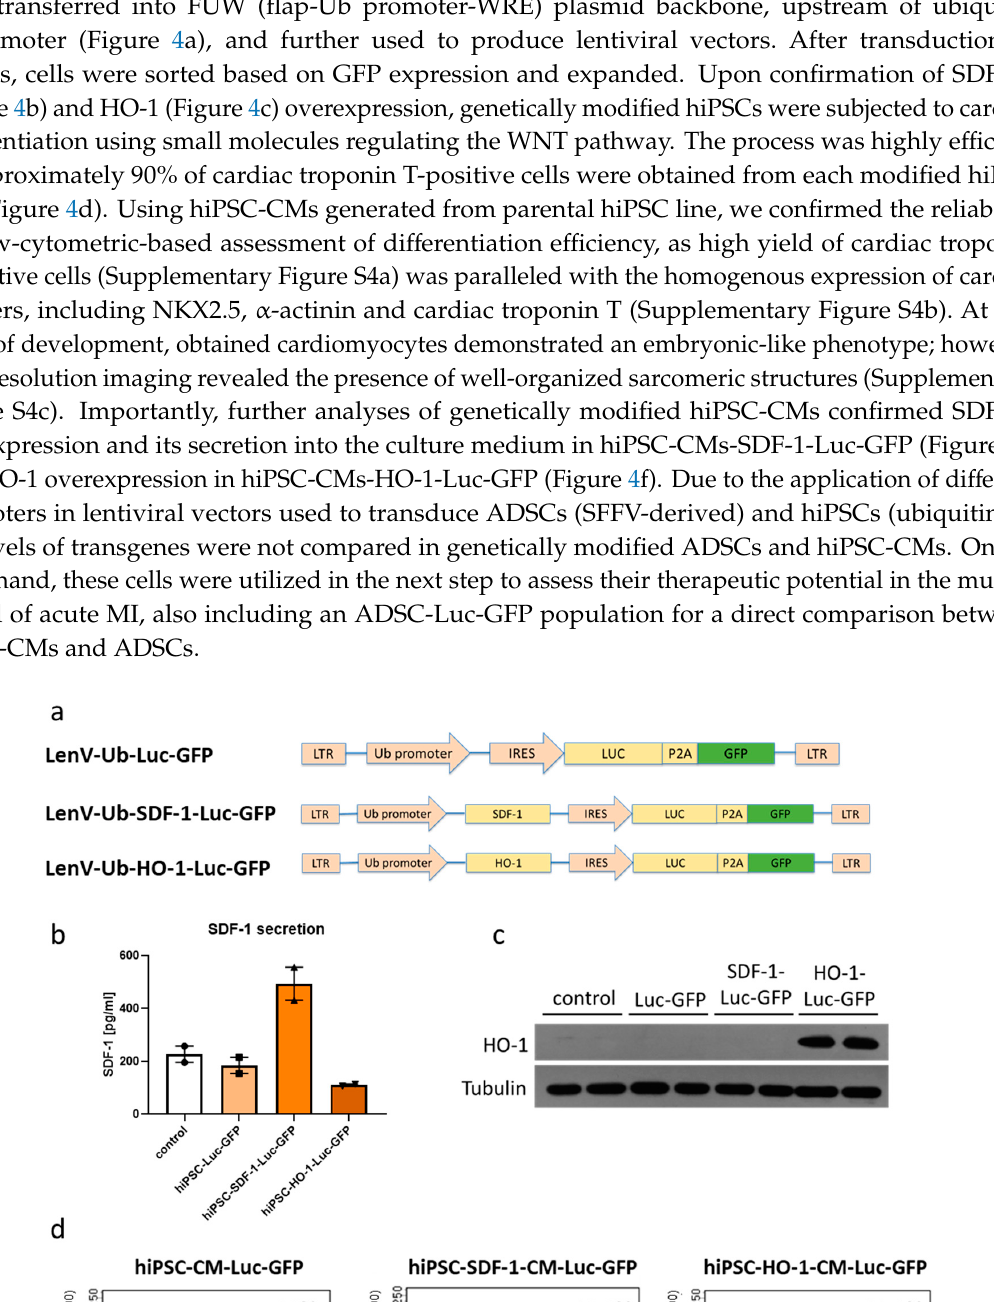
Figure 4. Generation of genetically modified human induced pluripotent stem cell-derived cardiomyocytes (hiPSC-CMs). ( a ) Schematic representation of lentiviral vectors used to transduce hiPSCs. Secretion of SDF-1 α ( b ) and expression of HO-1 ( c ) in transduced hiPSCs. ( d ) Cardiac differentiation efficiency of transduced and sorted hiPSCs measured as percentage of cells positive for cardiac troponin T (cTnT). Secretion of SDF-1 α ( e ) and expression of HO-1 ( f ) in genetically modified hiPSC-CMs. 3.4. Genetically Modified hiPSC-CMs Improve Heart Function in NOD/SCID Mice Subjected to MI As previous analysis indicated no ADSC retention in hearts of Nude mice, we used the NOD/SCID immunocompromised murine strain in the second set of in vivo experiments. NOD/SCID mice, in contrast to athymic Nude animals, lack not only T-cells but also B-cells and show decreased NK cell activity; thus, they are more receptive for human cell xenografts [23]. MI induction and cell administration were performed as described for the first set of in vivo experiments (Figure 2a); however, here we tested the therapeutic effect of genetically modified hiPSC-CMs and ADSCs-Luc- GFP. ADSCs-SDF-1-Luc-GFP and ADSCs-HO-1-Luc-GFP were not included, as overexpression of